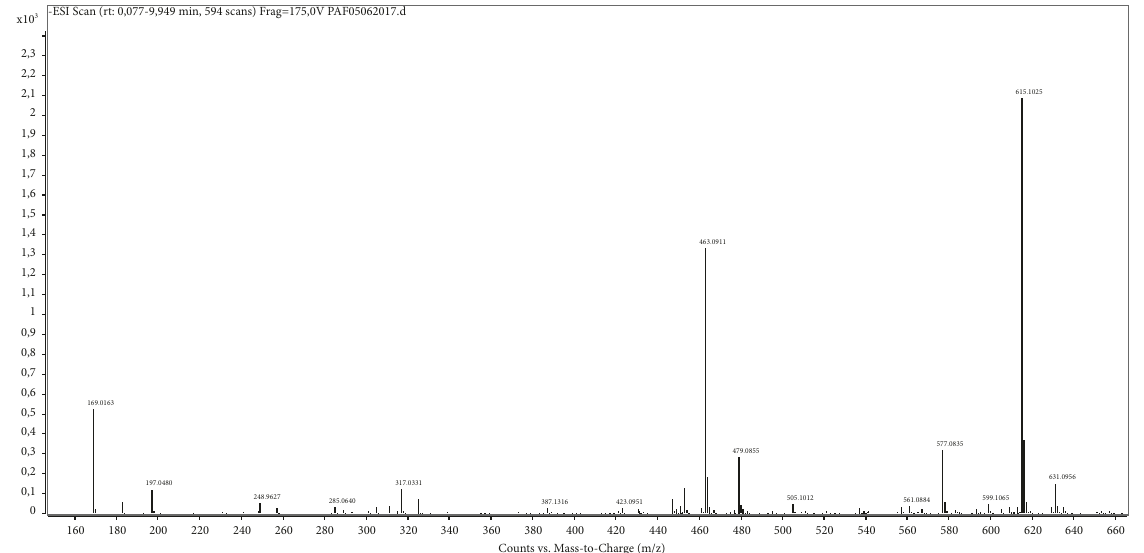
Figure 1: Total ion chromatogram of EAF obtained by